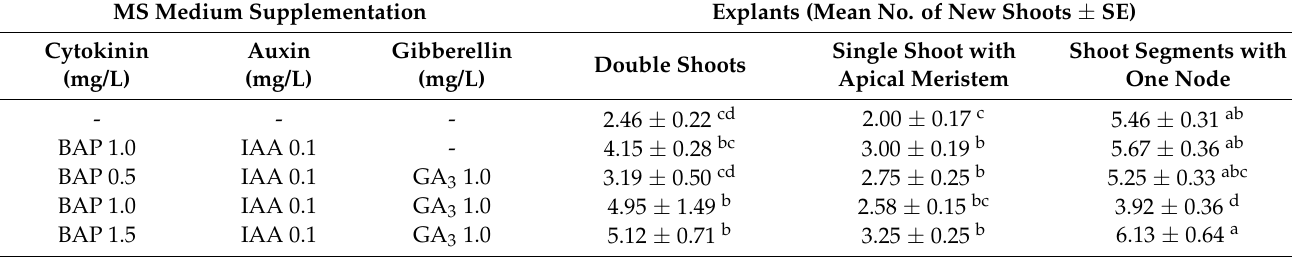
Table 1. The influence of the type of the plant explant and hormonal supplementation on Linnaea borealis var. borealis shoot multiplication on the solid MS